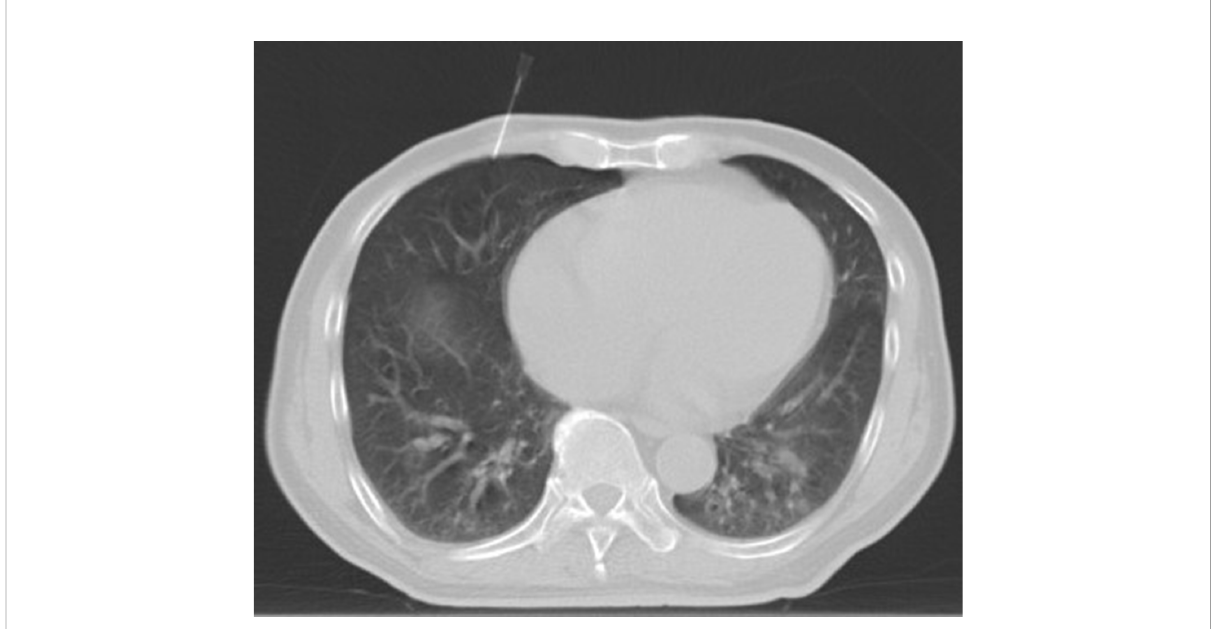
FIGURE 2 The arti fi cial pneumothorax was created: Intraoperative scan was acquired with the patient in the supine position. the examination couch was adjusted to the level of the diaphragm dome on the puncture side. When the bevel tip of the 5-ml syringe needle reached the pleura, the syringe would be removed, a transparent rubber tube would be connected, and a little sterile saline would be injected into the tube to form a water